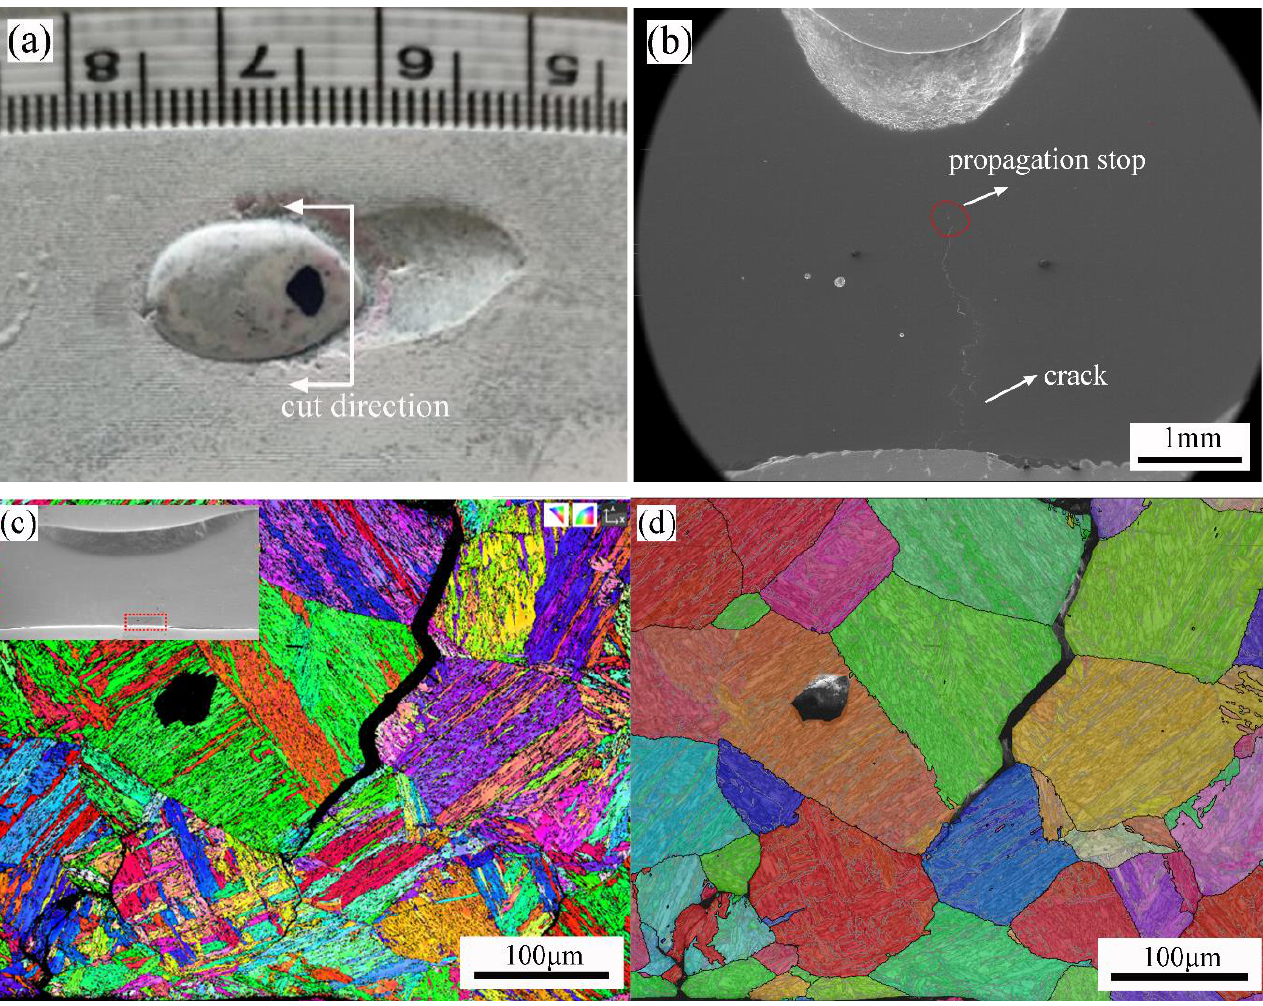
Figure 16. Failure behavior and mechanism analysis of DF zone: ( a ) schematic diagram of sample cutting; ( b ) morphology of crack; ( c ) IPF X; ( d ) prior austenite grain. cutting; ( b ) morphology of crack; ( c ) IPF X; ( d ) prior austenite